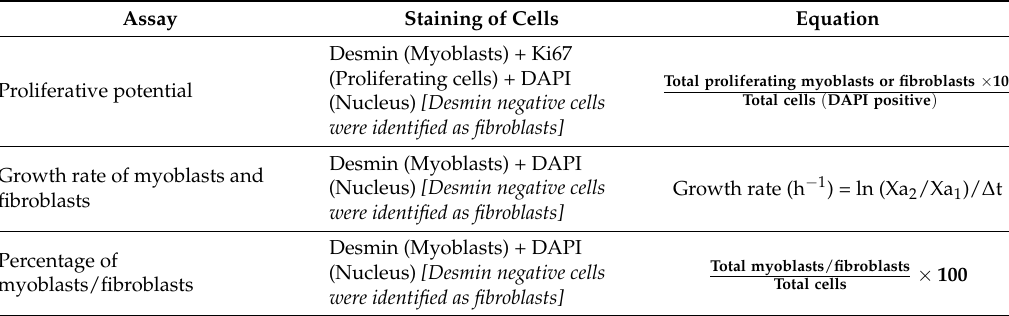
Table 2. The equation to evaluate proportion of myoblasts and fibroblasts, growth rate and proliferative